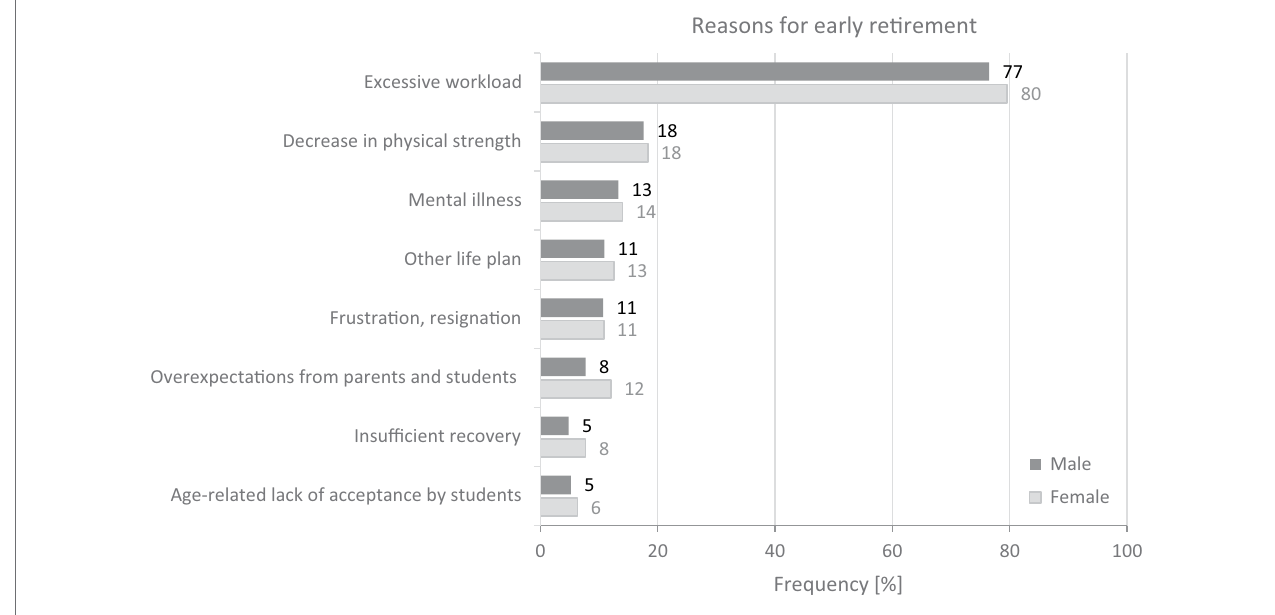
FIGURE 3 | Reasons for not reaching regular retirement of male ( n = 2,680) and female ( n = 3,429) full-time teachers (multiple responses